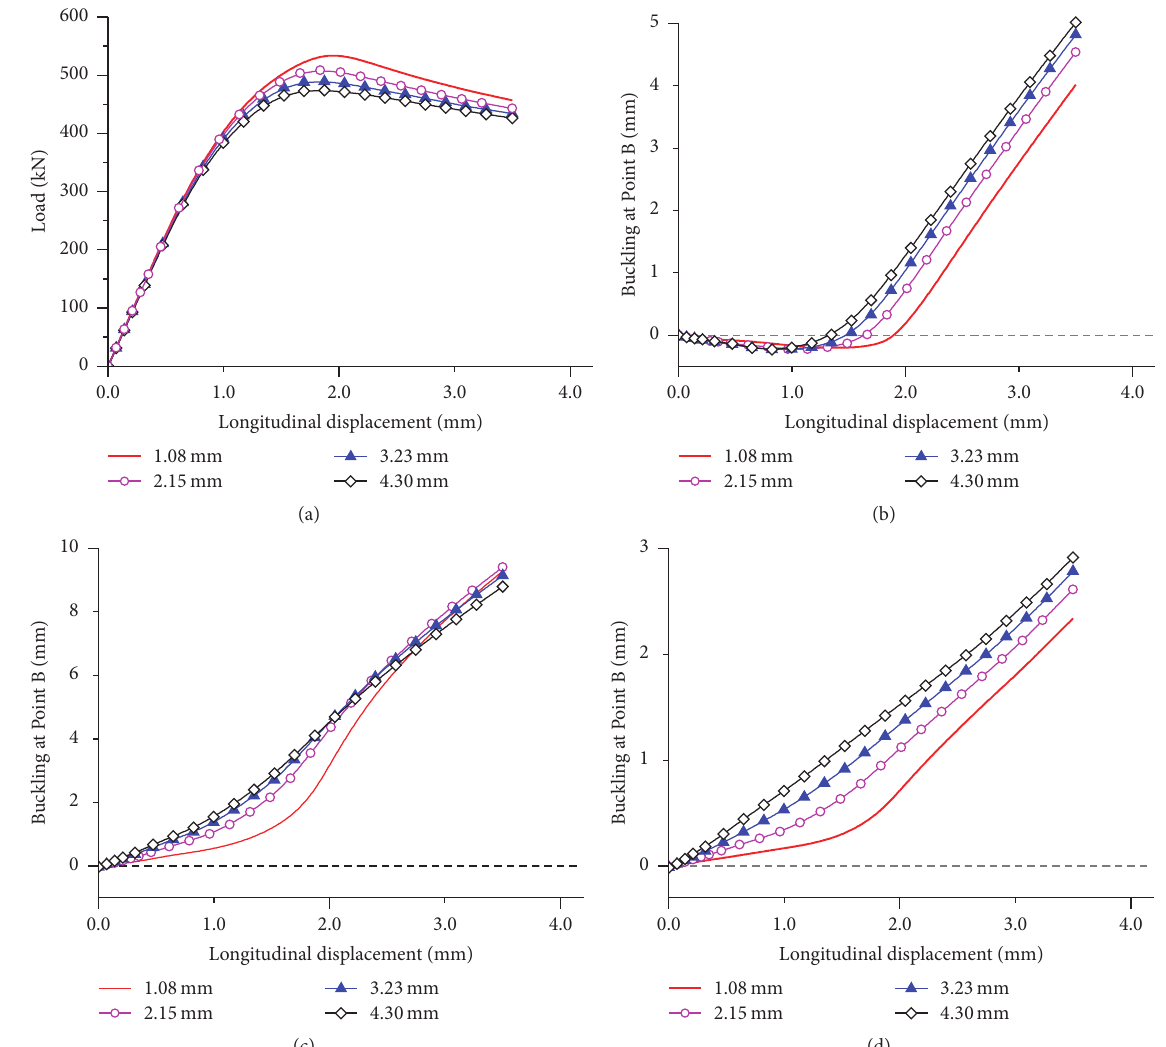
Figure 12: Load-displacement and buckling-displacement curves 3: (a) load-displacement curves; buckling-displacement curves at (b) Point A, (c) Point B, and (d) Point